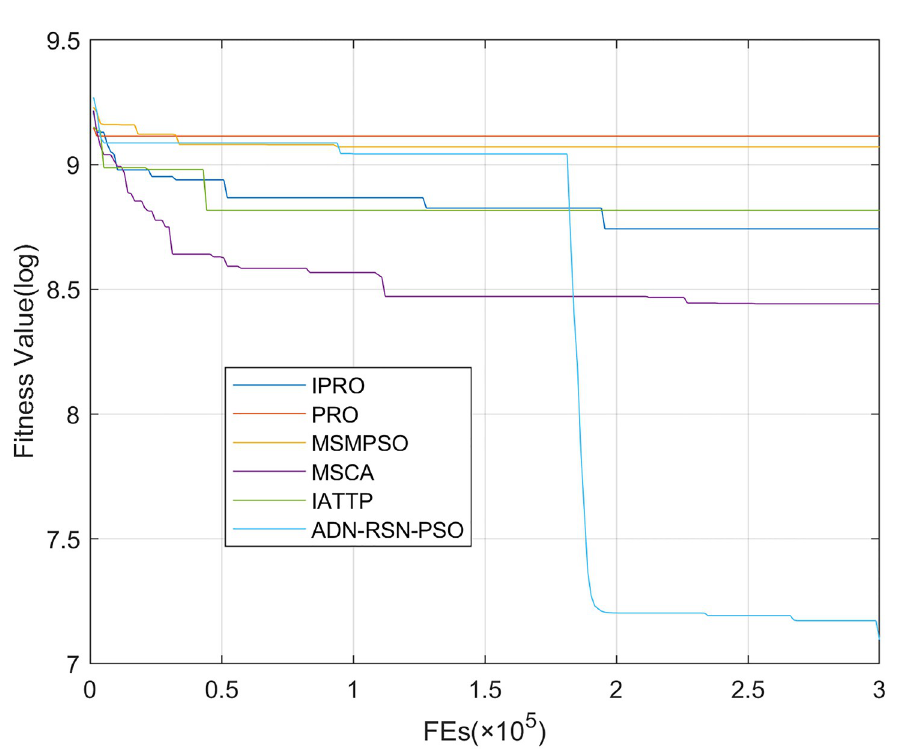
Fig 22. Convergence curves on F22.